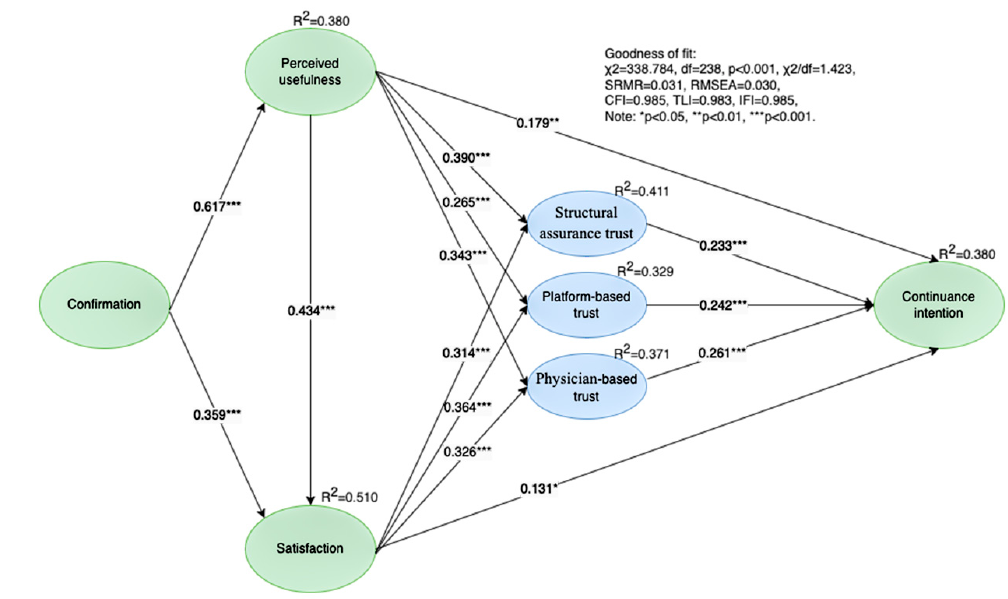
Figure 2. Results of the research model. Table 4. Results of hypothesis testing and mediation effects.